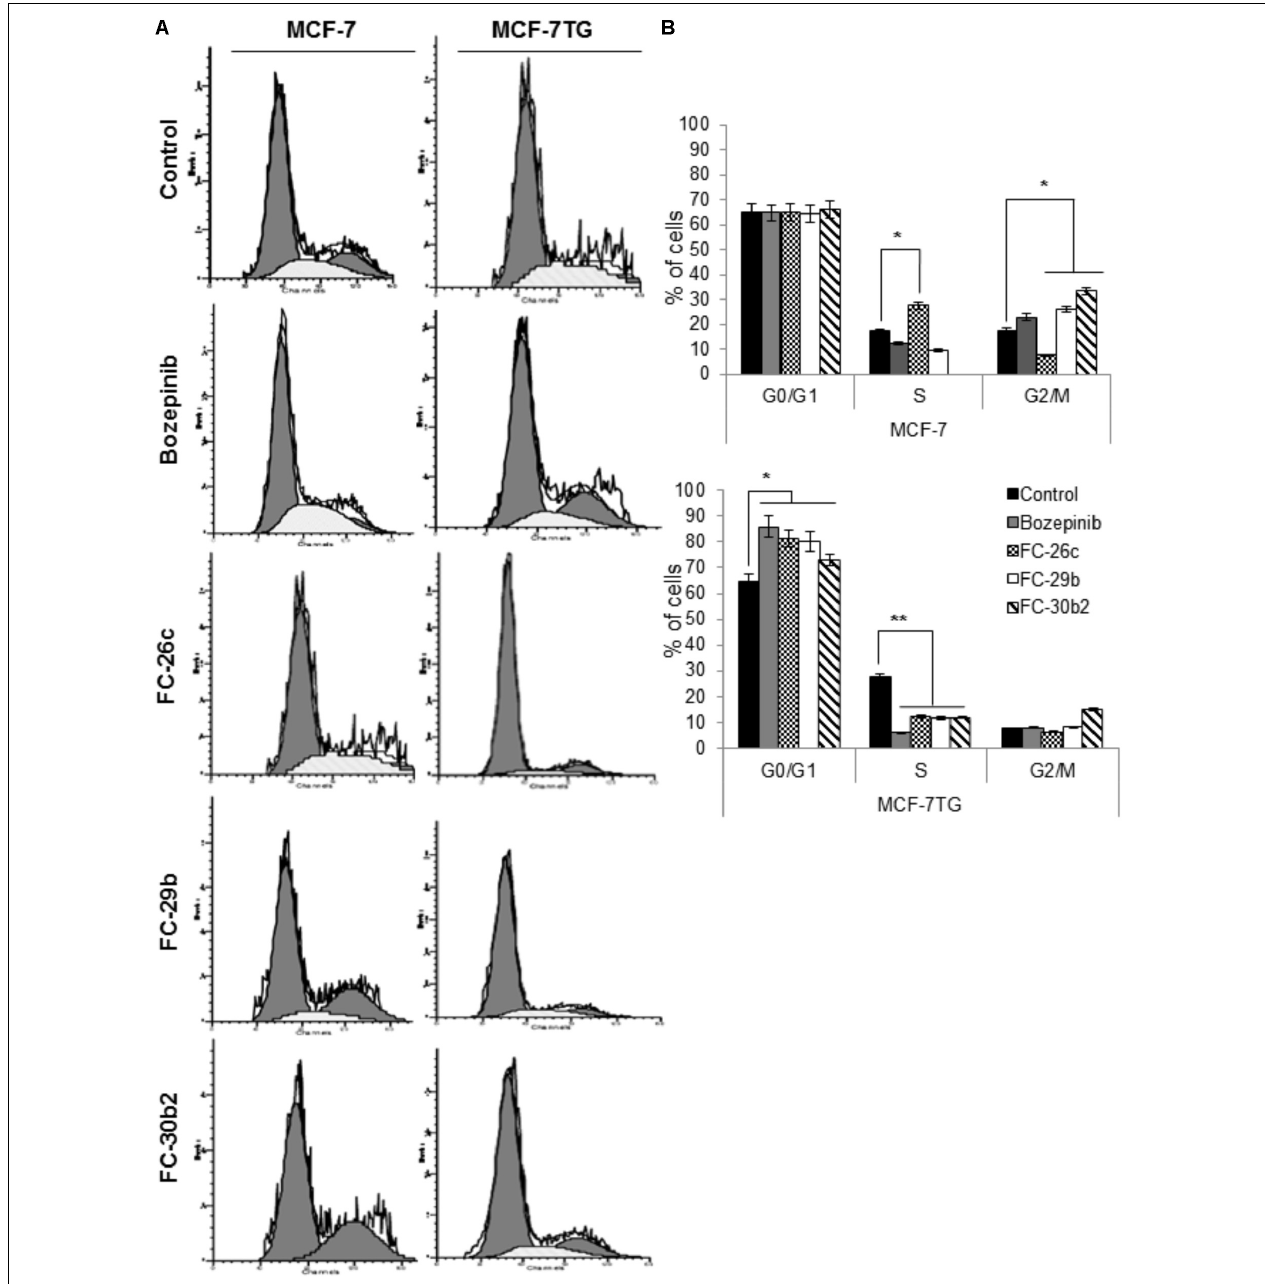
FIGURE 6 | Combination of gef gene expression and drugs induce cell cycle arrest in G0/G1. MCF-7 and MCF-7TG cells were mock-treated (control) or treated with IC 50 of bozepinib, FC-26c, FC-29b, and FC-30b2 for 72 h. Then, cells were trypsinized and analyzed by FACScan to distinguish populations of cells in different phases of the cycle as described in the section “Materials and Methods.” (A) Representative images from flow cytometry analysis. (B) Data are expressed as the mean ± standard error of the mean of three independent experiments. ∗ P < 0.05, ∗∗ P < 0.01 ( t